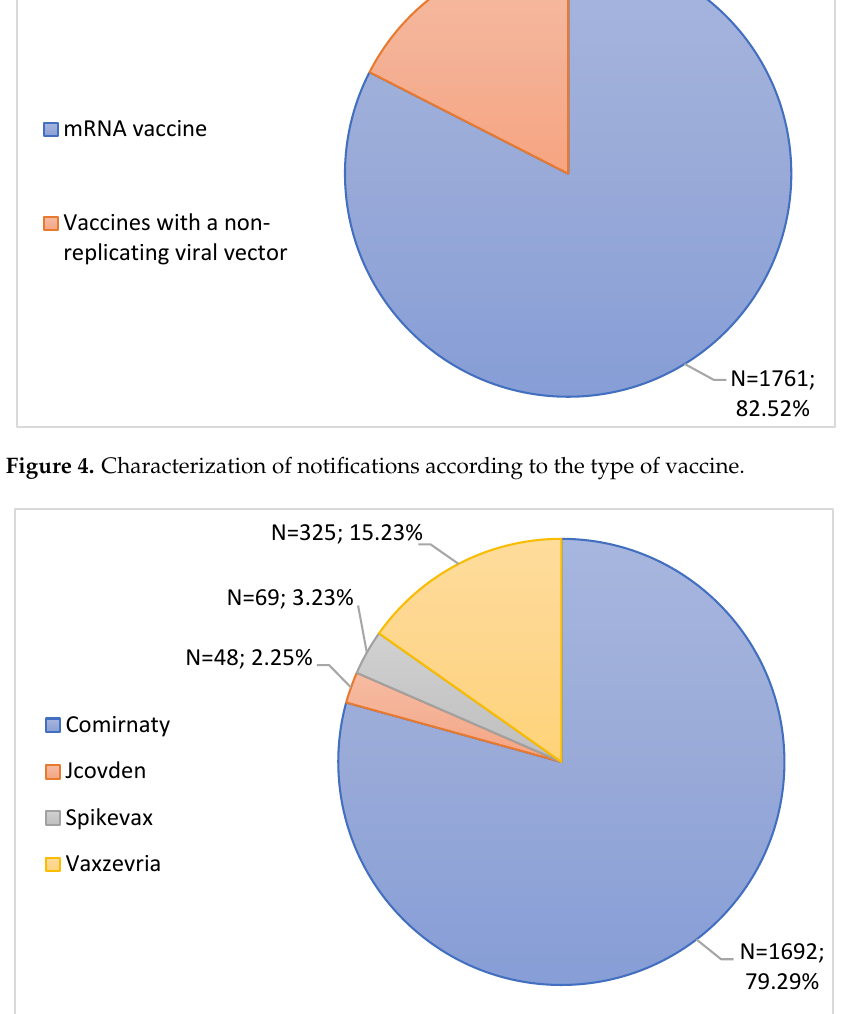
Figure 4. Characterization of notifications according to the type of vaccine.